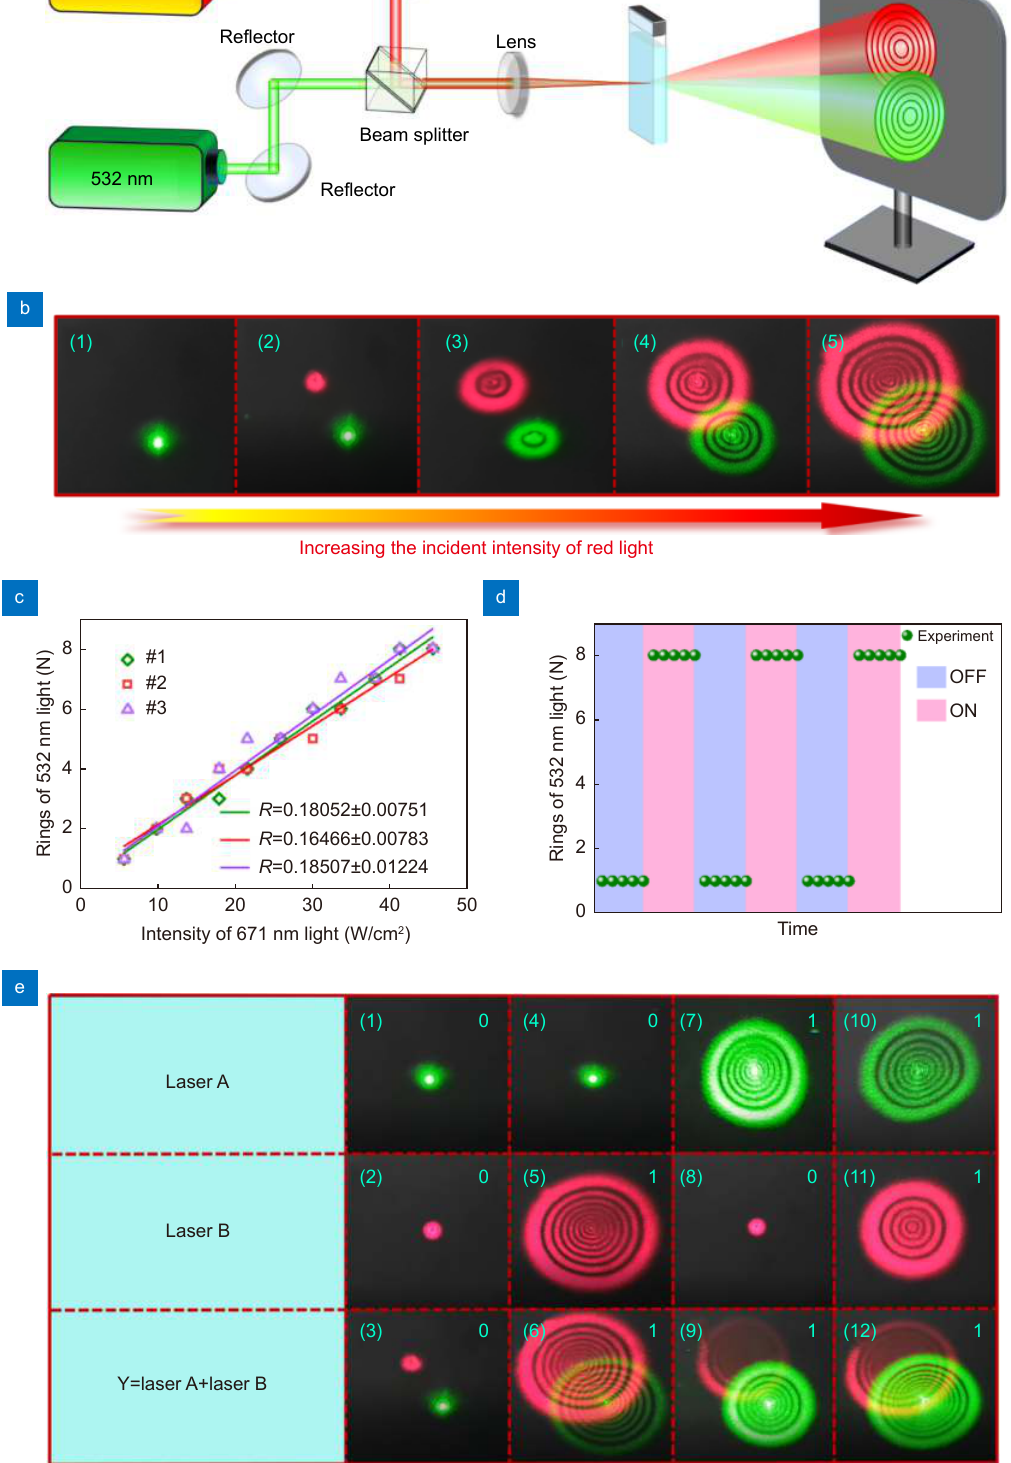
Fig. 5 | ( a ) Experimental schematic of the 2D B-AsP-based all-optical phase modulated system. ( b ) The phase modulation of controlling light to signal light. ( c ) The number of diffraction rings modulated by the intensity of controlling light. ( d ) Result of the all-optical switching based on 2D B- AsP NSs to realize the functions of “on” and “off”. ( e ) 2D B-AsP NSs all-optical logical gate to achieve the “or”